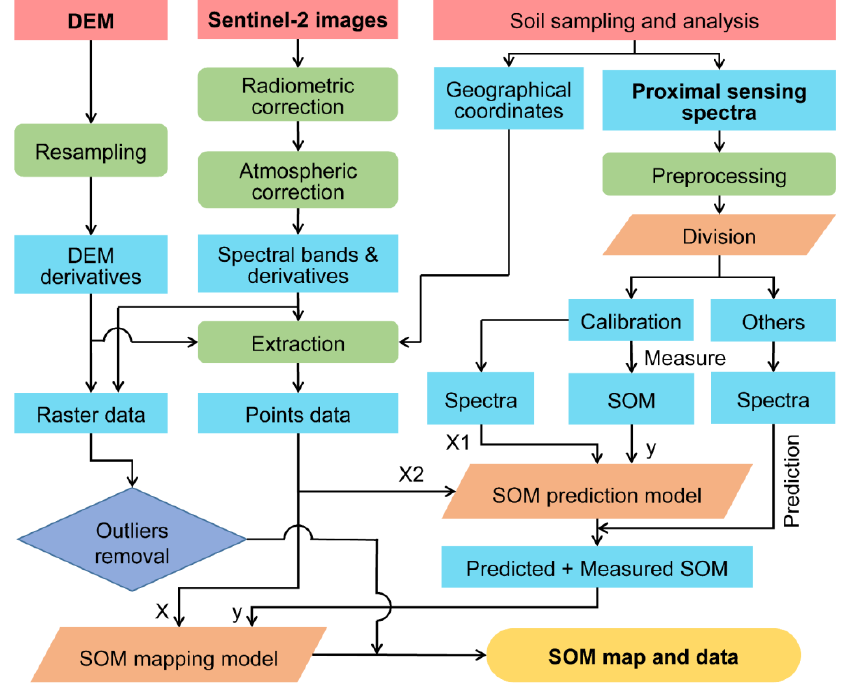
Figure 2. Detailed flowchart of the framework for data obtaining, processing, and modeling.